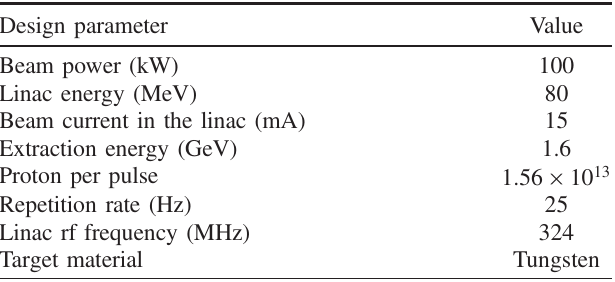
TABLE I. The basic design parameters of CSNS. Design parameter